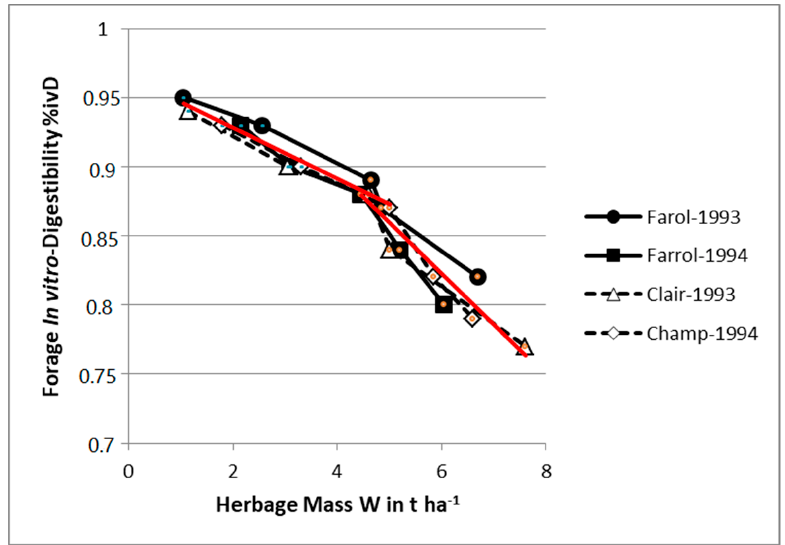
Figure 5. Decrease in forage digestibility during the herbage mass accumulation process in spring for meadows of timothy ( Phleum pratense L.) in Eastern Canada for two consecutive years, according to different cultivars having either early or late phenology (flowering stage). The initial regression until herbage mass W ≈ 5 t ha − 1 is %Div = − 0.019W + 0.97 (R 2 = 0.937), and the final regression for W > 5 t ha − 1 is: %Div = 0.037W + 1.04 (R 2 = 0.873). Data obtained at Fredericton (45.55° N; 66.36° W; Canada) and redrawn from Bélanger and McQueen [33].